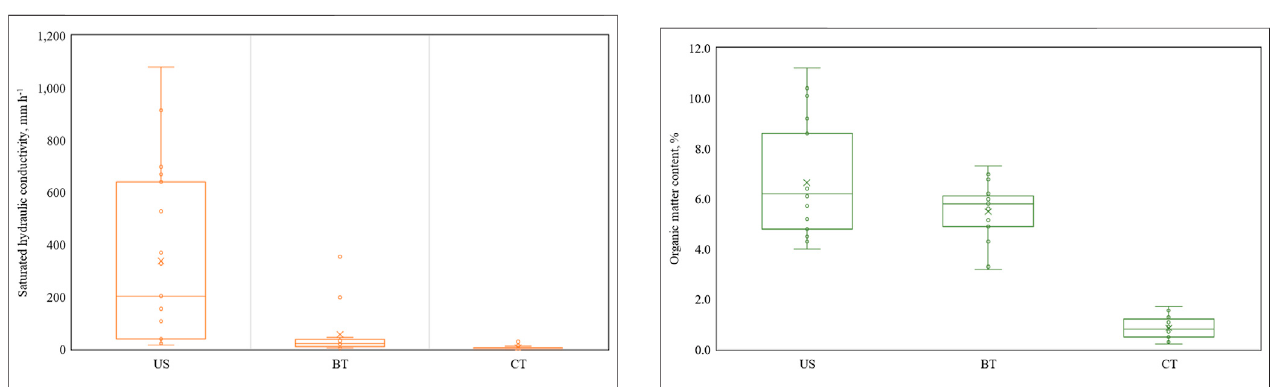
FIGURE 7 | Box and whisker plots of organic matter content among the disturbed types; undisturbed and shallow disturbance (US), bladed skid trail (BT),andcompacted roadsurface(CT).ThecirclesaredataandthelineandX are mean value.